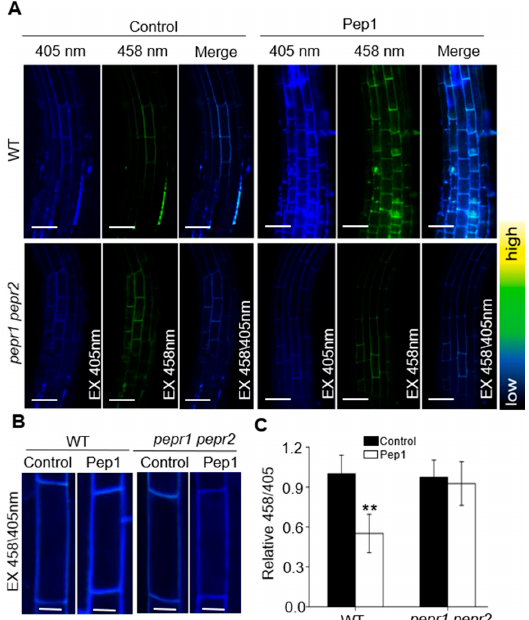
Figure 2. Pep1-PEPR induces the acidification of apoplast in root apex. ( A ) The 8-hydroxypyrene-1,3,6-trisulfonic acid trisodium salt (HPTS) fluorescence signals in 6-day-old wild-type (WT) and pepr1 pepr2 roots treated with or without (Control) 100 nM Pep1 for 8 h. The root-apex fluorescent signals represented protonated HPTS (EX405) (Excitation 405 nm, emission peak 514 nm), deprotonated HPTS form (EX458) (Excitation 458 nm, emission peak 514 nm), and the merge of EX458/EX405, Bars = 50 μ m. Color code (black to yellow) depicts (low to high) 458/405 intensity. ( B ) Representative pictures of the cortex cells in transition zone, Bars = 10 μ m. ( C ) The summarized values on fluorescent ratio of deprotonated HPTS to protonated HPTS in the cortex cells of transition zone, as indicated in (B). The fluorescent ratio of the control (WT) was set to 1.0, and the Pep1 treatment ratio was normalized to the control ratio. Data are mean ± SD from three independent experiments ( n = 16 cells from 8 roots per treatment). Asterisks indicate statistically significant differences compared with Control (Tukey’s test; ** p < 0.01).